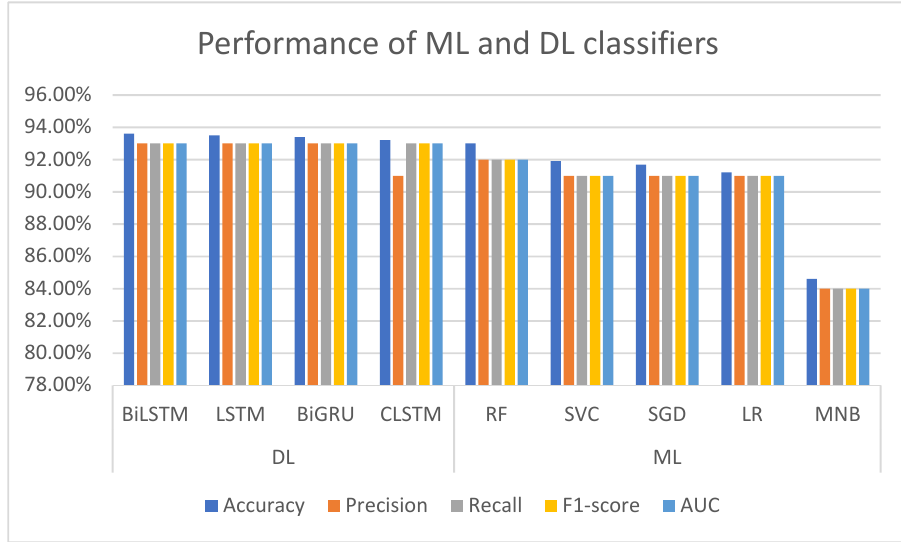
Figure 5. Accuracy score for ML models.